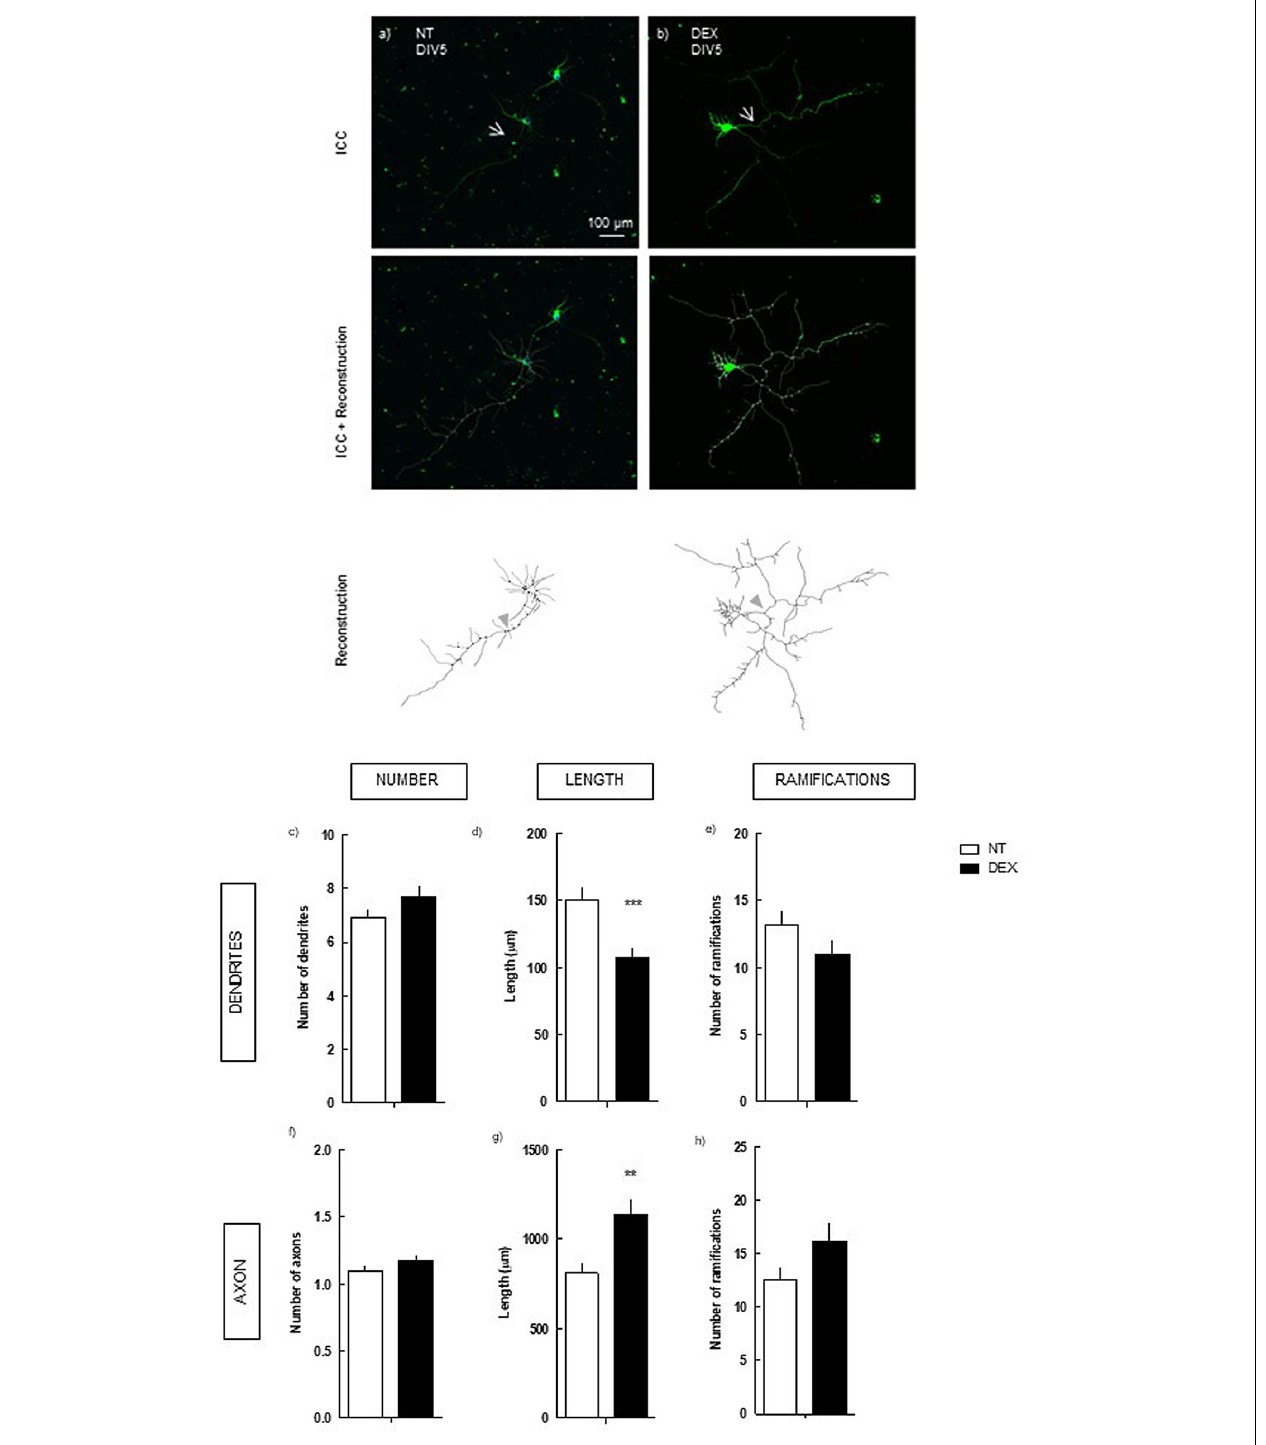
FIGURE 1 | Effect of DEX treatment (4 days treatment) on hippocampal neurons (DIV5). Hippocampal neurons from ED18 rats were cultured in vitro for 5 days (DIV5) and treated with DEX (250 nM) at 24 h in culture. Neuronal morphology was assessed by manual reconstruction in Neurolucida software (a,b) and morphometric data were acquired in Neurolucida Explorer, regarding the number (c) , length (d) and number of ramifications (e) of dendrites and the number (f) , length (g) , and number of ramifications (h) of axons (identified with an arrow in the representative images). Results are expressed as mean ± SEM of 120 cells, from five independent experiments. Statistical significance was assessed by t -student test: ∗∗ p < 0.01, ∗∗∗ p < 0.001, comparing DEX treatment with NT. ICC, immunocytochemistry; NT, non-treated; DEX, dexamethasone.